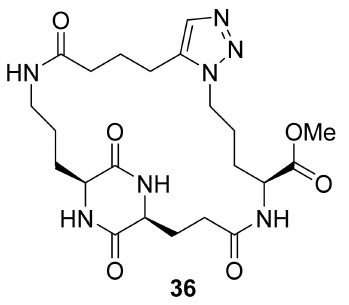
Figure 16. Example of peptidomimetic synthesis using the diversity-oriented synthesis (DOS)